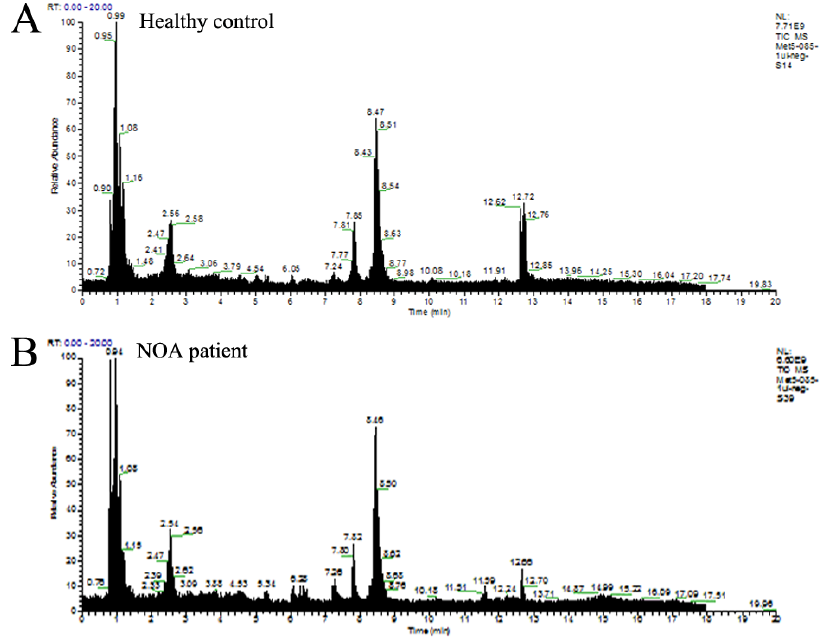
Figure 1. Representative base peak intensity chromatographic profiles of healthy control subject ( A ); and non-obstructive azoospermic patients ( B